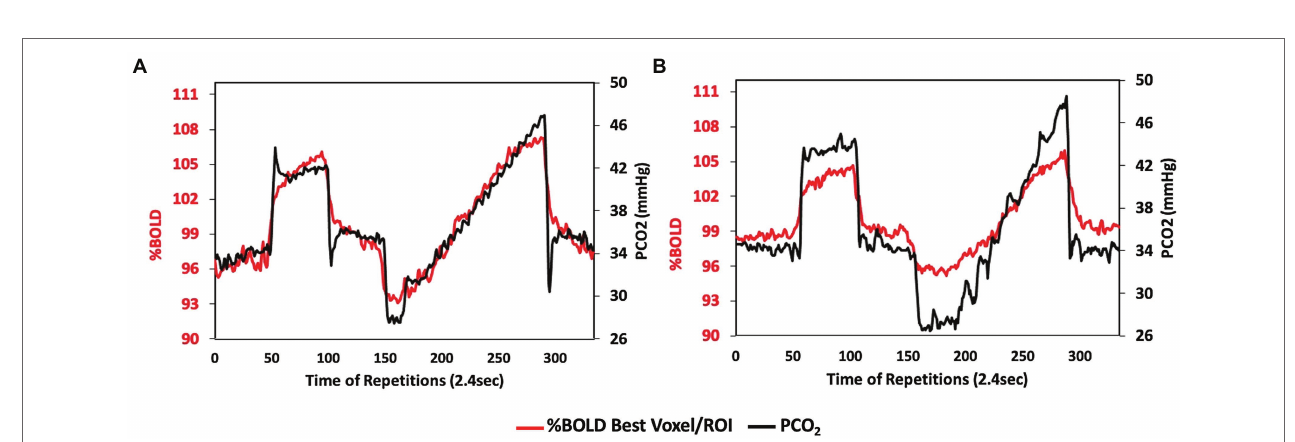
FIGURE 9 | Reproducibility of the stimulus. Data from a 46-year-old female being followed for progressive narrowing of intracranial segments of both internal carotid and middle cerebral arteries. CVR scan in (A) was performed 2 years prior to CVR scan in (B) to assess the progress of hemodynamic compromise. Note the high reproducibility of the stimulus. This reproducibility enables the dampening flow response (red line) in (B) to be attributed to the vascular